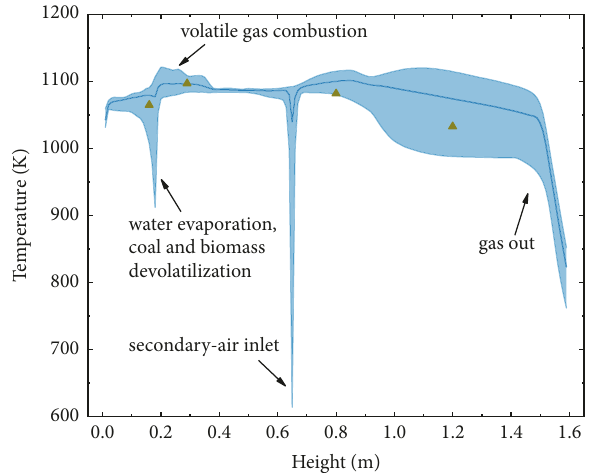
Figure 7: The curve: time- and section-averaged temperatureof gas and the shadow region: time-averaged temperature range along the axial height.